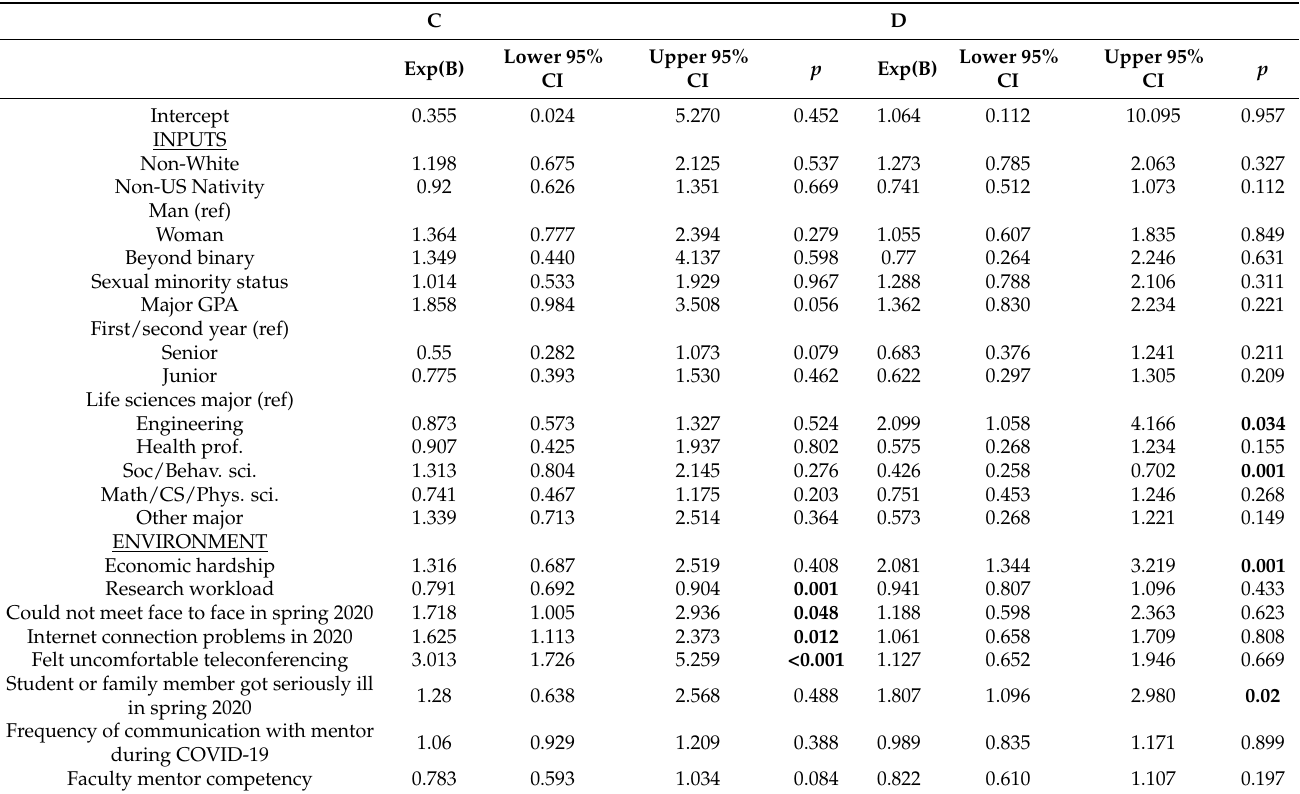
Table 4. GEE models predicting the odds of undergraduate researchers (C) experiencing research task uncertainty and (D) lacking the tools needed to do research.